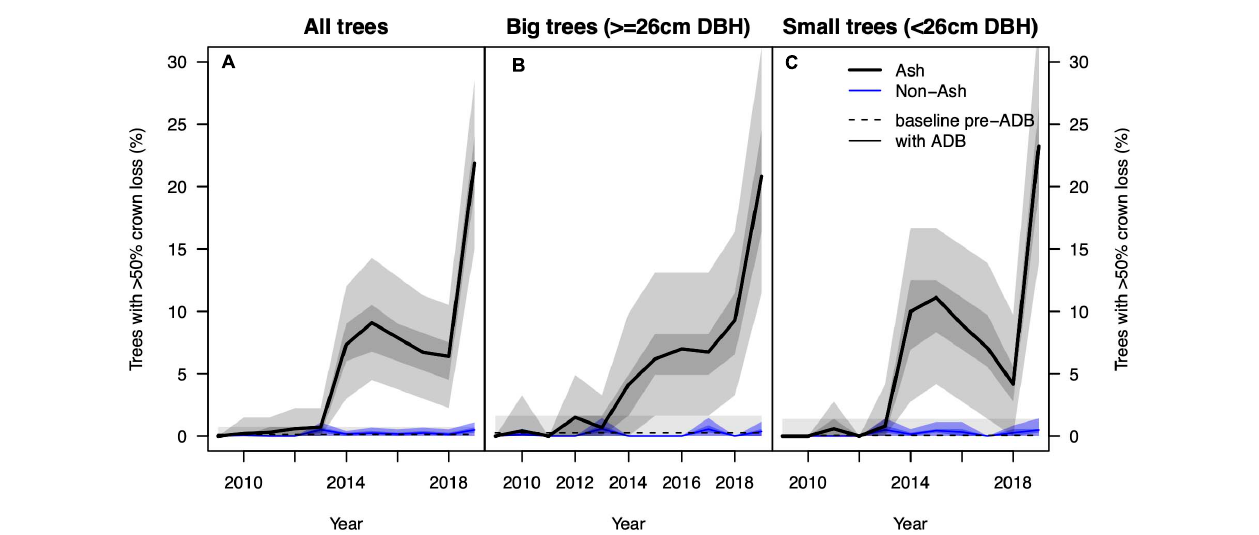
FIGURE 1 | (A) Observed percentage of ash (solid black line) and non-ash trees (blue line) with > 50% crown loss based on data from the National Forest Inventory. The dashed black line denotes the “background” percentage of Fraxinus excelsior with > 50% crown loss before the arrival of the fungus. The shadings around the solid lines show the interquartile range (dark) and 95% confidence interval (light) after 1,000 iterations of resampling with replacement. Panels (B,C) show the same information for big ( ≥ 26 cm DBH) and small trees ( < 26 cm DBH), respectively. Please note only the data pairs 2009/2018 and 2010/2019 comprise the same trees (excluding ingrowth and